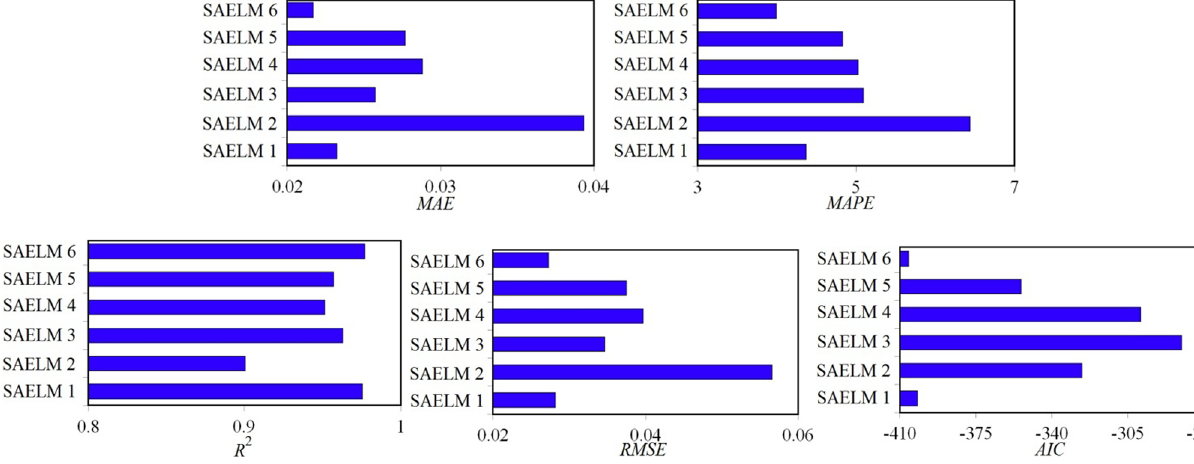
Fig. 7 Changes of different statistical indices for SAELM 1 to SAELM 6